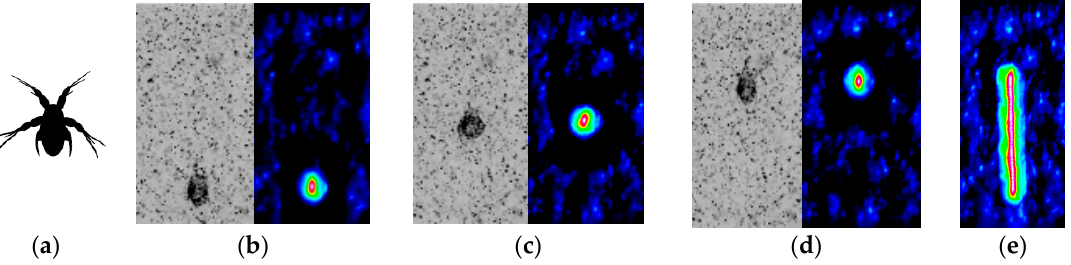
Figure 15. ( a ) Schematic of Acartia Tonsa nauplius during a power stroke. ( b – d ) Raw particle image and the cross-correlation of the 0.2 mm-tall organism with the ( b ) first, ( c ) middle, and ( d ) last frames of 65 frames. ( e ) A. Tonsa ’s nearly linear trajectory during the experiment.